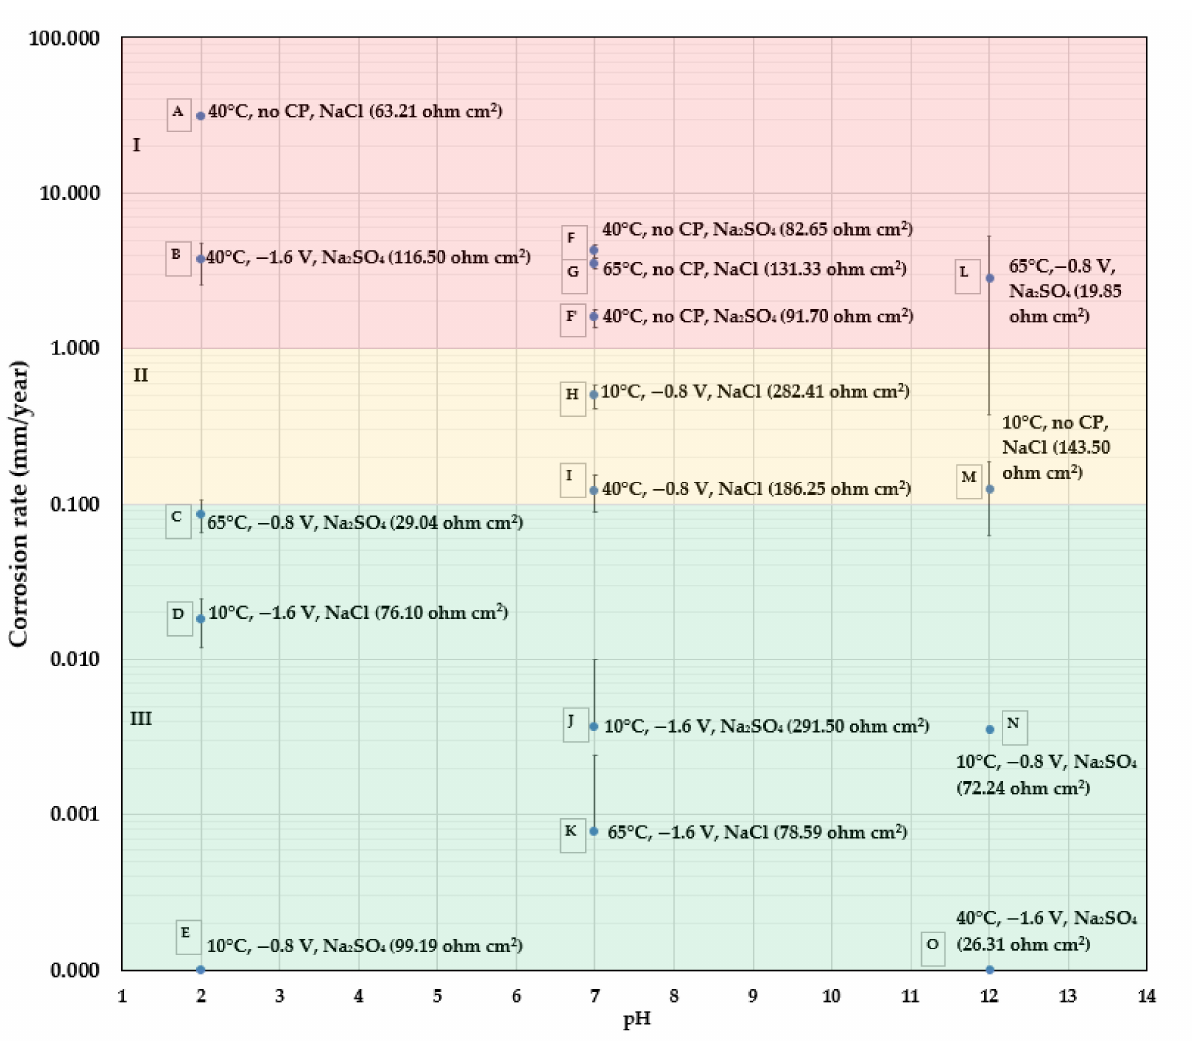
Figure 4. CR map of bare X60, small electrode samples, under different test conditions using the weight loss data (the data in the bracket is the electrolyte resistance estimated from EIS